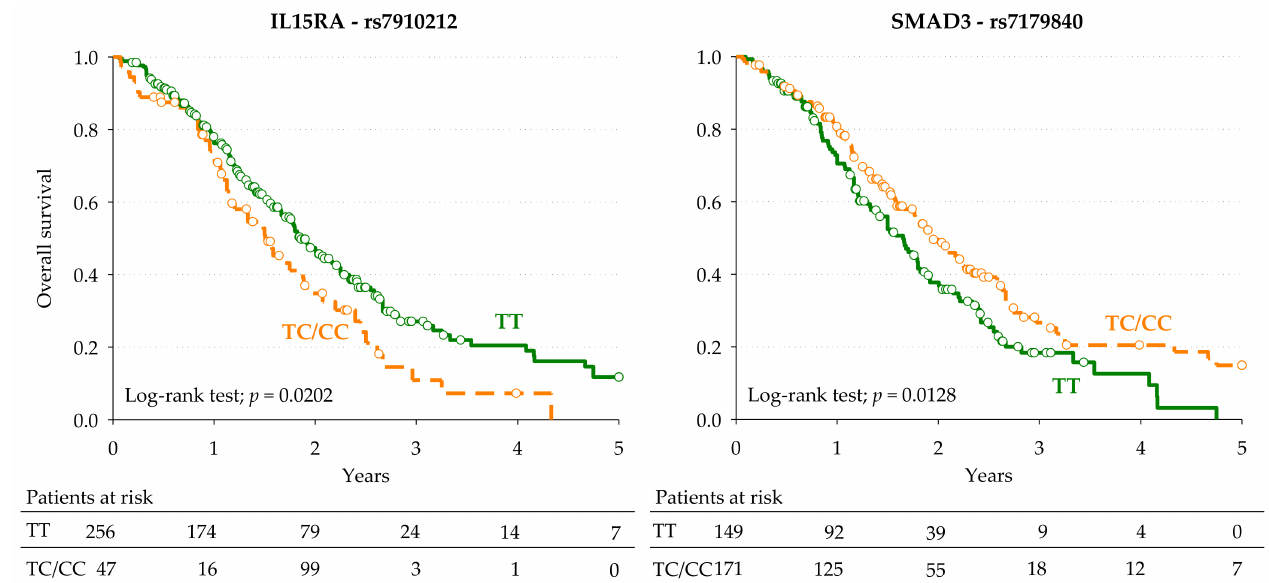
Figure 2. Kaplan-Meier estimates of overall survival according to the selected IL15RA -rs7910212 and SMAD3 -rs7179840 polymorphisms in the combined discovery and replication cohorts (pooled population, n =